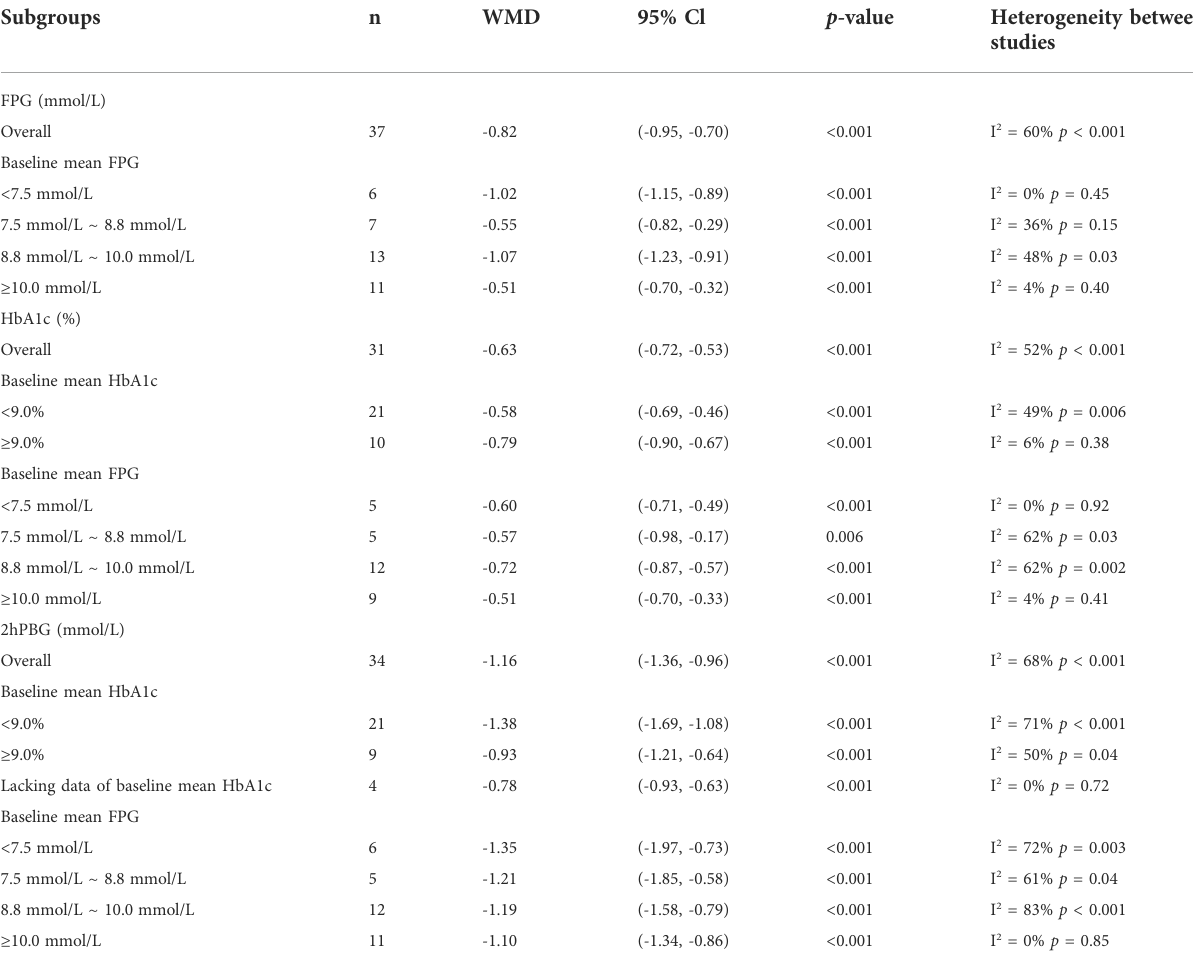
TABLE 5 The results of subgroup